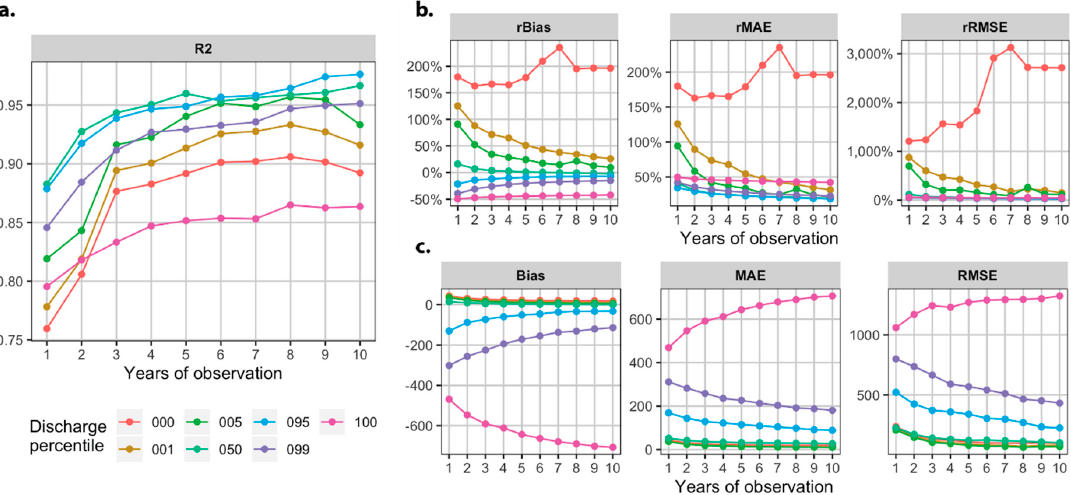
Figure 5. Landsat’s representation of flow conditions with increasing observation duration . ( a ) Variations in R 2 value with increasing observation duration. ( b ) Relative metrics (rBias, rMAE, rRMSE) comparing gauge daily records and Landsat-sampled gauge records. ( c ) Absolute error metrics (Bias, MAE, RMSE, unit: cms) comparing gauge daily records and Landsat-sampled gauge records. Median statistical values plotted for each